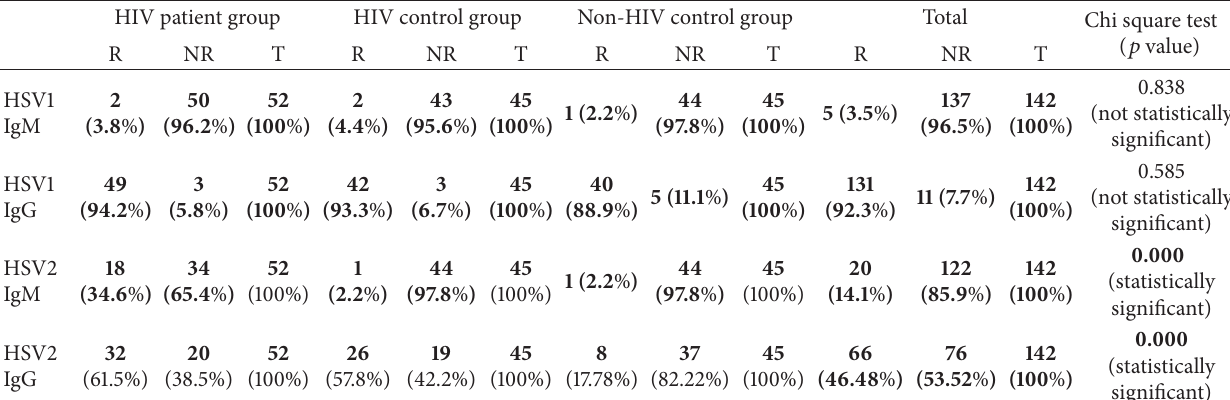
Table 4: Seroprevalence of HSV-1 and 2 antibodies (IgM and IgG) in different study groups. HIV patient